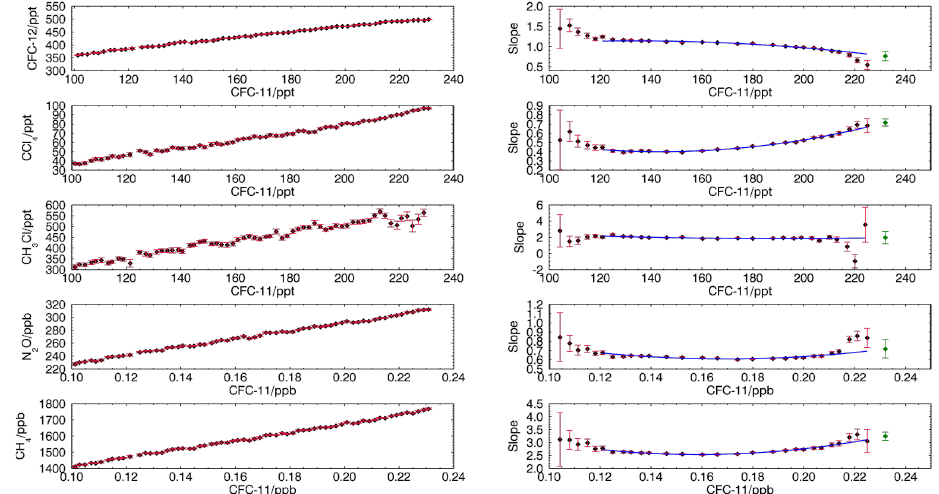
Figure B10 Correlations between the volume mixing ratios of CFC-12, CCl 4 , CH 4 , CH 3 Cl and N 2 O and CFC-11 for the data from the northern hemisphere during the stratospheric winter of 2010. Left panels: The mean correlation profile. Each point represents the mean of the VMR in a window of 2 ppt of CFC- 11. The error on these points is the standard deviation of the data within each 2 ppt window. Right panels: The local slope of data in an 80 ppt of CFC-11 window. The error on the points is the fitting error of this fit. The blue line is a second degree polynomial fit to the local slopes. The green point is the extrapolated slope at the tropopause.